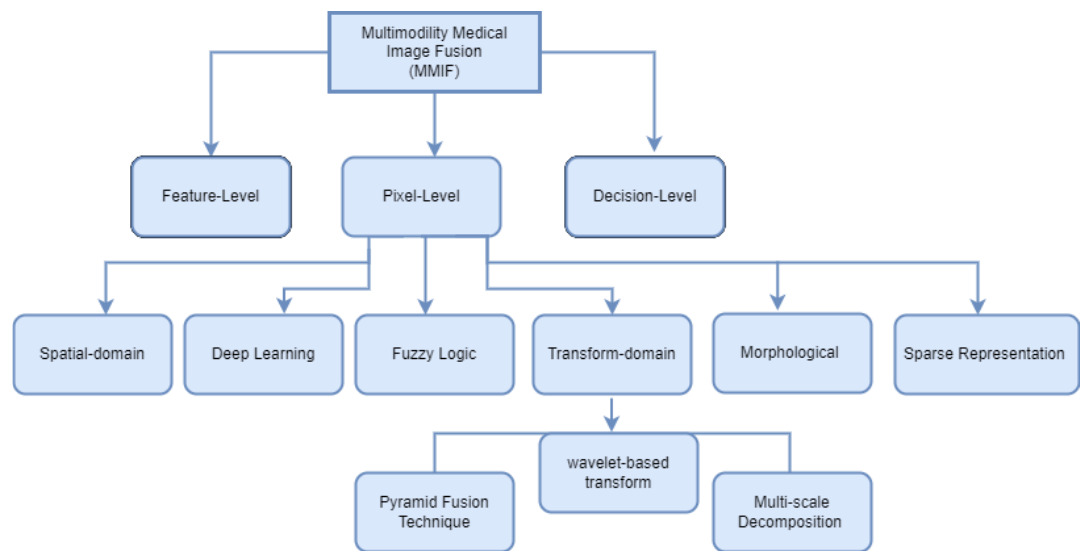
Figure 4. Multimodal Medical Image Fusion techniques classification.